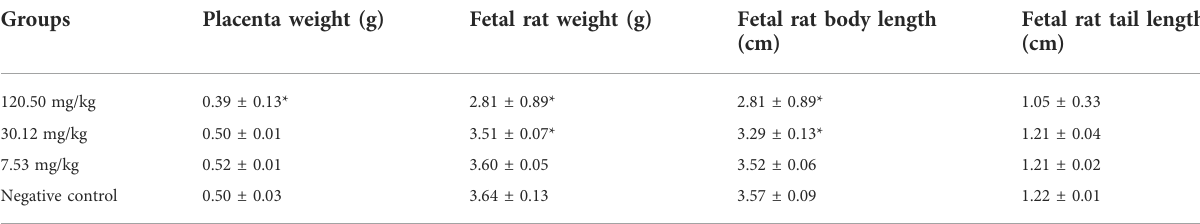
TABLE 5 Effect of MPTA on the development of rat embryos (n = 12).